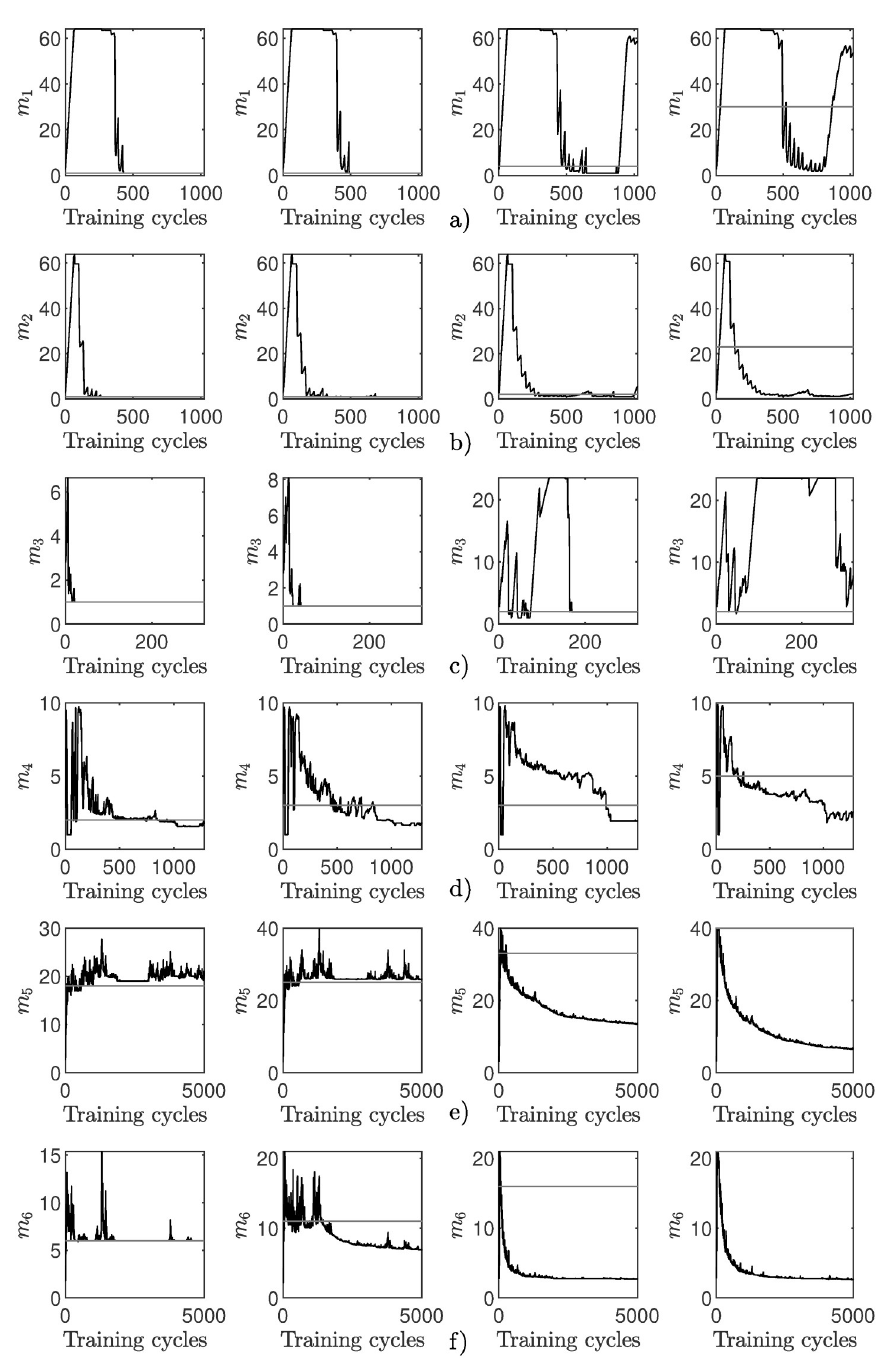
Fig 9. Incremental PCA [8] on the cumulative percentage of total variance stopping rule. The first plot in each row has a proportion of θ 1 = 0.70, the left-middle plot of θ 2 = 0.80, the right-middle plot of θ 3 = 0.90 and the right plot of θ 4 = 0.99: (a-f) shows the results obtained on each data set 1 corresponding to Table